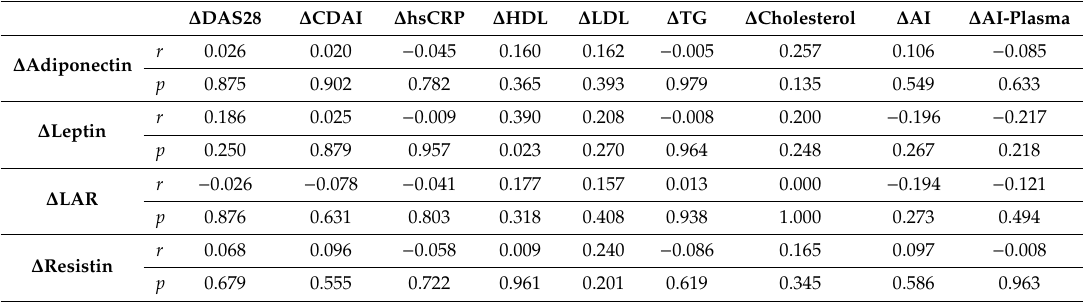
Table 4. Correlation between the changes in adipokine levels and clinical and biochemical parameters of RA reflecting cardiovascular disease (CVD) risk and disease activity, before and after four months of TCZ treatment. ∆ DAS28 ∆ CDAI ∆ hsCRP ∆